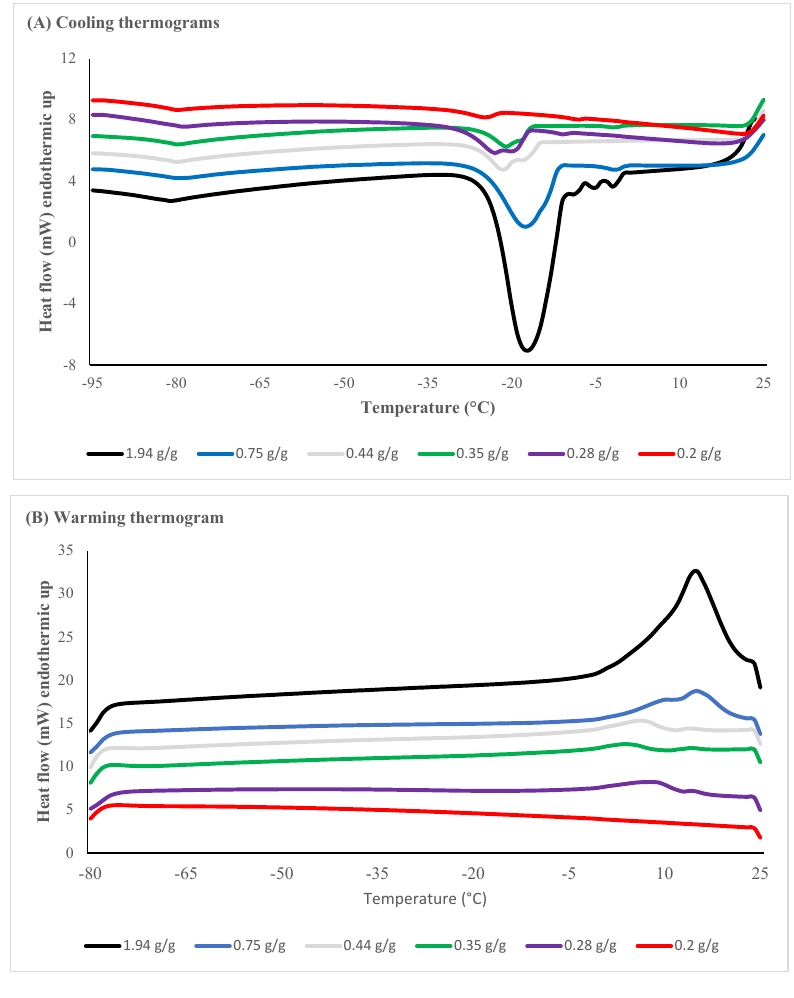
Figure 4. Differential Scanning Calorimetry warming ( A ) and cooling ( B ) thermograms for Syzygium maire embryonic axes (EAs) following rapid desiccation to various moisture contents (MC). The results are for a single EA, which was rapidly desiccated for 0 min (solid black line), 60 min (blue line), 120 min (solid light grey line), 150 min (green line), 180 min (purple line), or 210 min (red line) to achieve indicated MC levels.